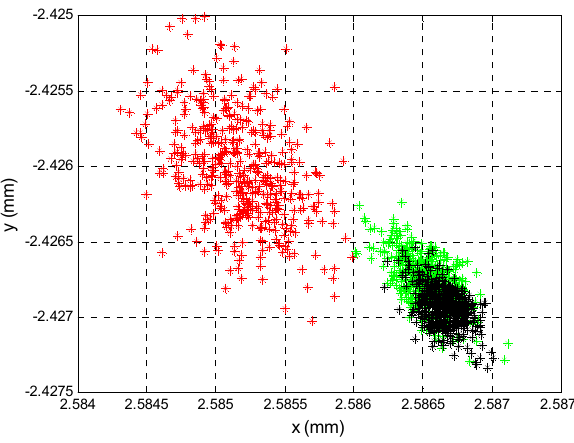
Figure 26. Error due to quantization noise with 6 bits (39 dB, red), 8 bits (51 dB, green) and 10 bits (61 dB, black).